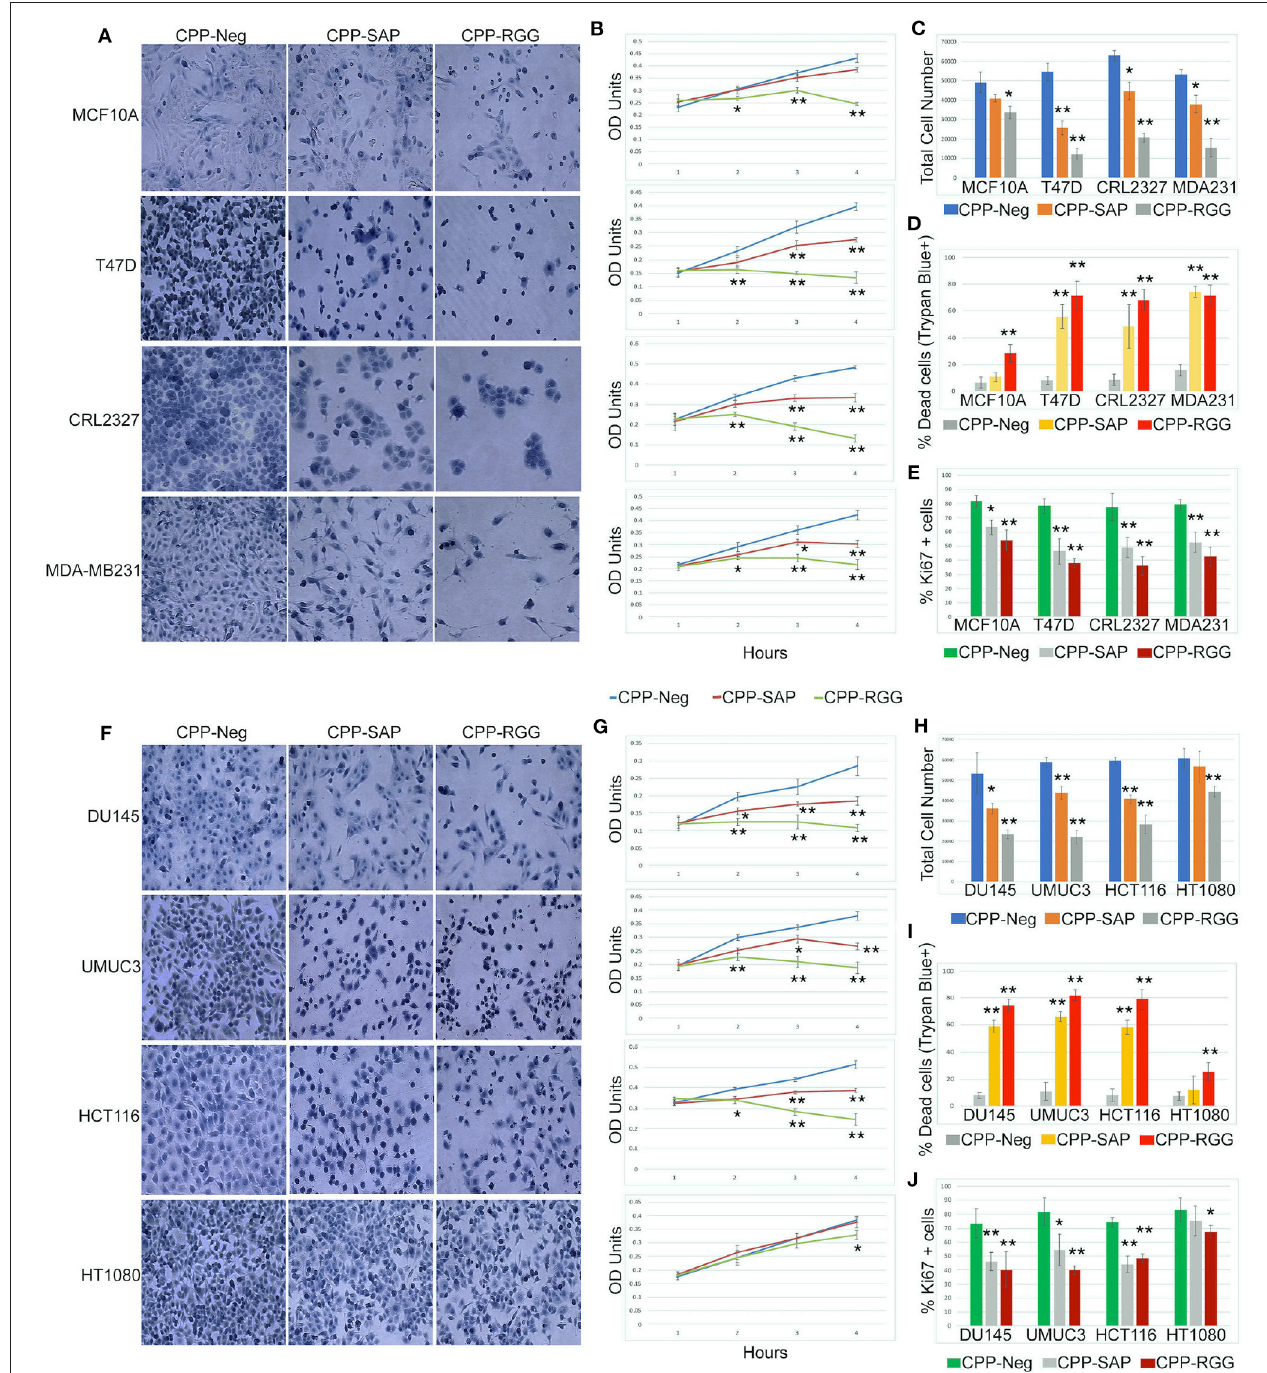
FIGURE 2 | Cell-penetrating SAFA-derived peptides reduce proliferation of a wide range of cells. (A) Representative light microscopic images of crystal violet stained MCF10A, T47D, CRL2327, and MDA-MB231 cells treated with SAFA-derived peptides (listed at top), for 48h at 10 µ M. (B) Crystal violet assay of MCF10A, T47D, CRL2327, and MDAMB 231 cells treated with CPP-Neg, CPP-SAP, and CPP-RGG peptides over the course of 48h (1 = 0, 2 = 12, 3 = 24, 4 = 48). (C–E) Quantification of total cell number, dead cells as measured by trypan blue staining and Ki67 + cells after 24h of CPP-Neg, CPP-SAP, CPP-RGG, and CPP-Act peptide treatments. (F–J) As in (A–E) with additional cell lines. * p < 0.05, ** p < 0.01 relative to control.